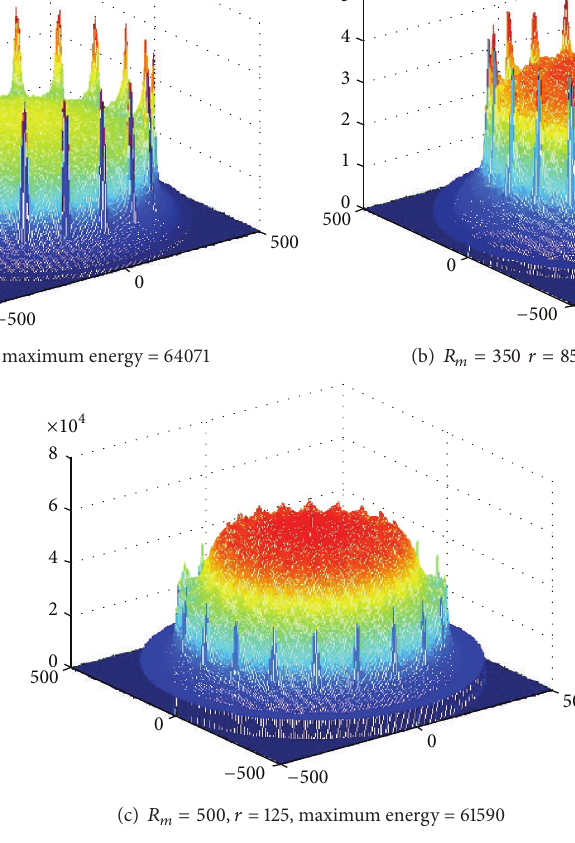
Figure 28: Energy consumption under different transmission range (theoretical value, 𝑅 = 500 , rounds = 20, anchors =